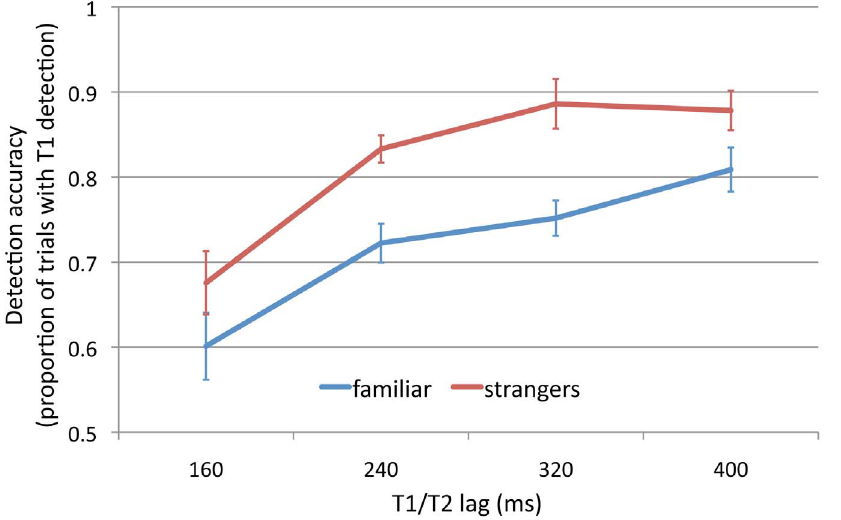
Figure 2. Results for each lag during the attentional blink. Personally familiar faces were detected more frequently than were faces of strangers during the attentional blink.